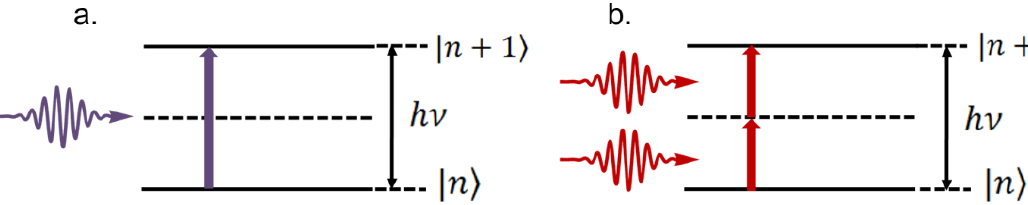
Figure 1. Energy diagram representing the absorption of ( a ) one and ( b ) two photons with the same energy to promote the electronic transition between the states |𝑛⟩ e |𝑛 + 1⟩ . Reprinted with permission [40]. Licensed under a Creative Commons Attribution 4.0 International license.